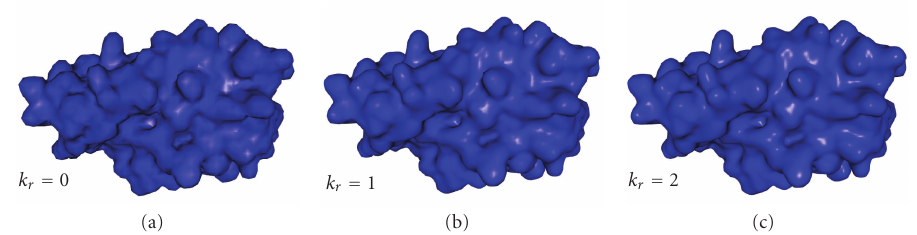
Figure 9: Meshes refined with a factor of k r = 0 (a), k r = 1 (b), and k r = 2 (c) (PDB code: 3EBZ).